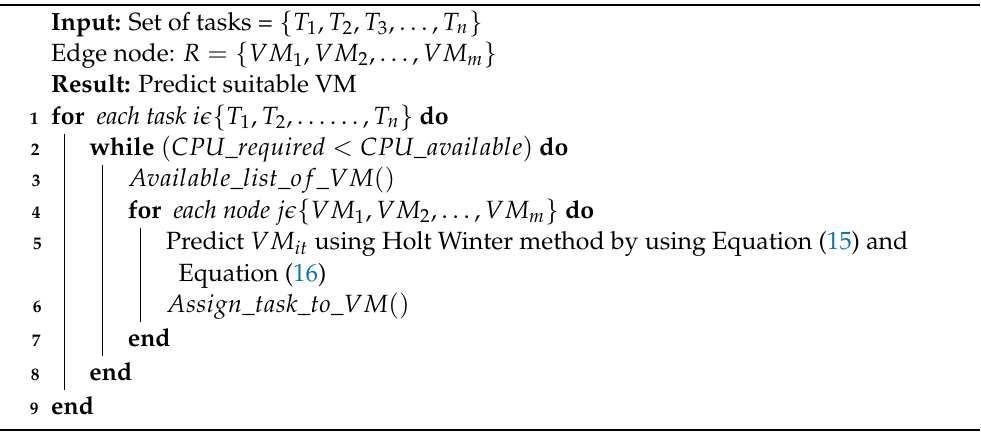
Algorithm 3: VAR-based multivariate algorithm